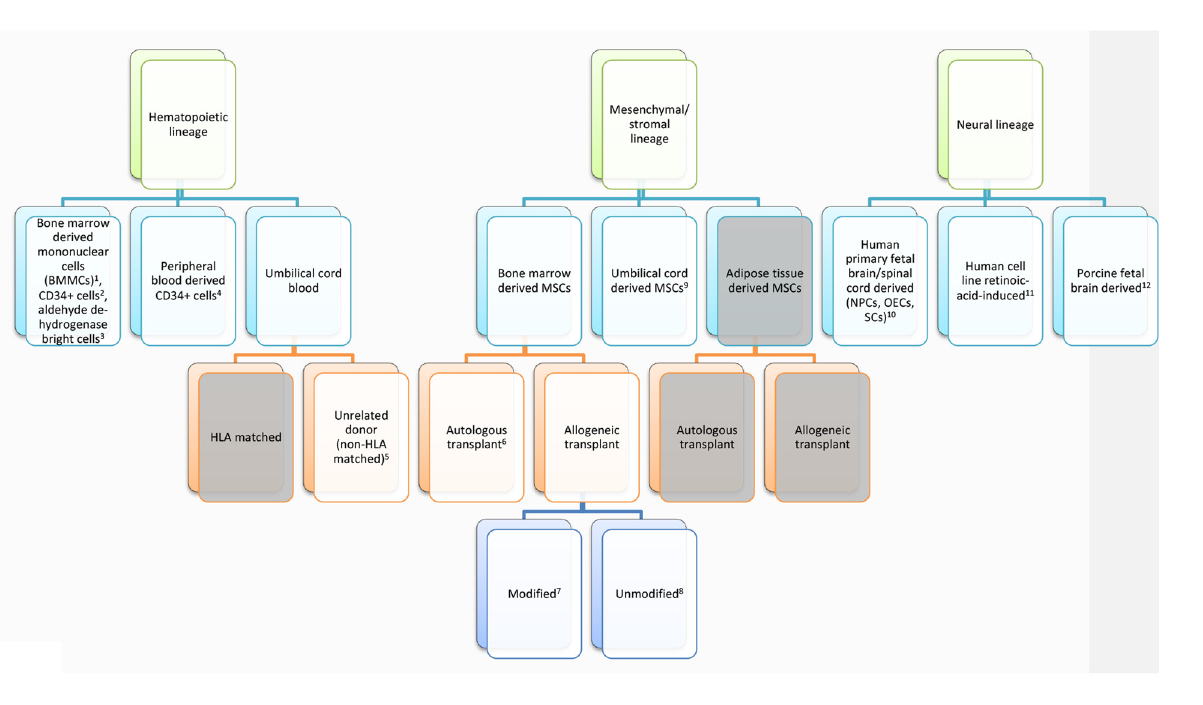
TABLE 1 | Lineage origin of transplanted cells in published clinical trials for ischemic stroke.